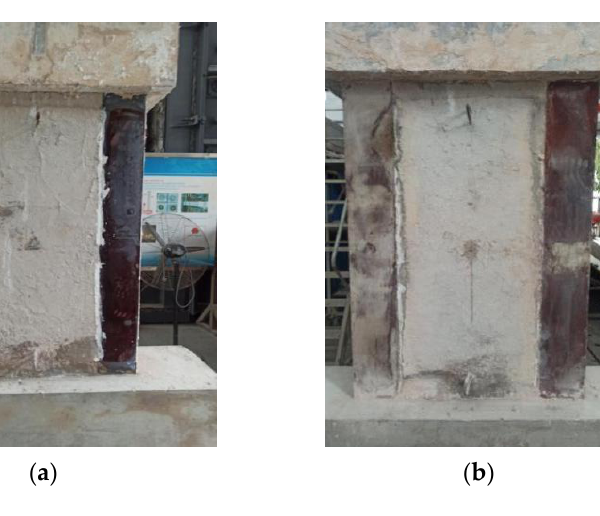
Figure 9. Patterns of specimen after fire. ( a ) SW2; ( b ) SW3; ( c ) SW4.